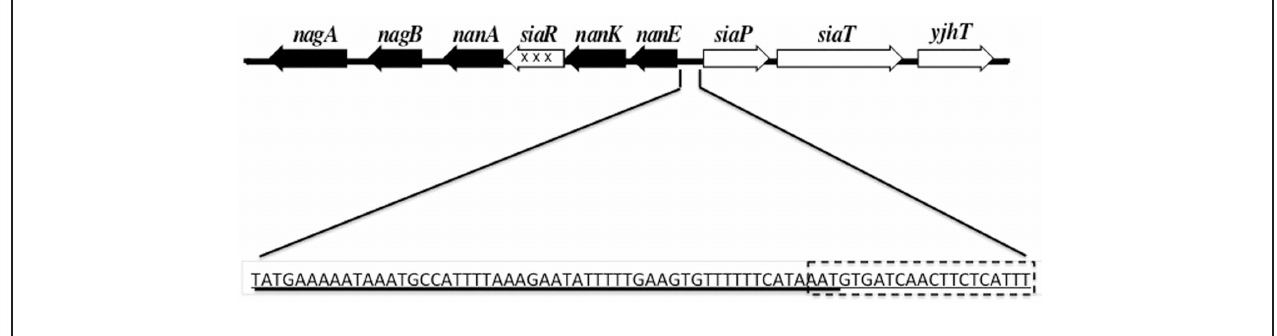
FIGURE 1 | A diagrammatic representation of the catabolic ( (cid:2) ), uptake genes ( (cid:3) ), and regulatory gene ( (cid:4) ) of the two Sia operons in the H. influenzae genome are diagrammed in Figure